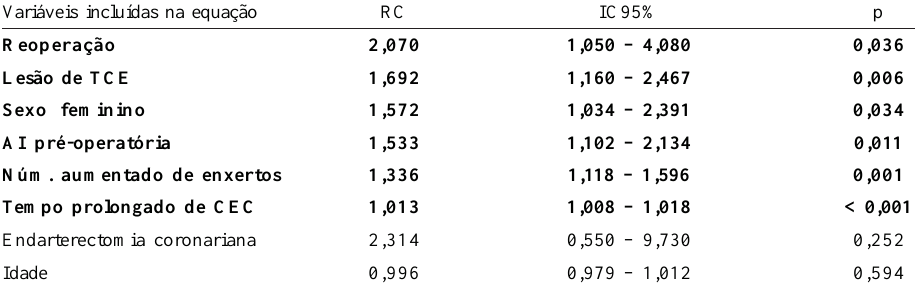
Tabela 3. Variáveis preditoras independentes para a ocorrência de infarto do miocárdio perioperatório Variáveis incluídas na